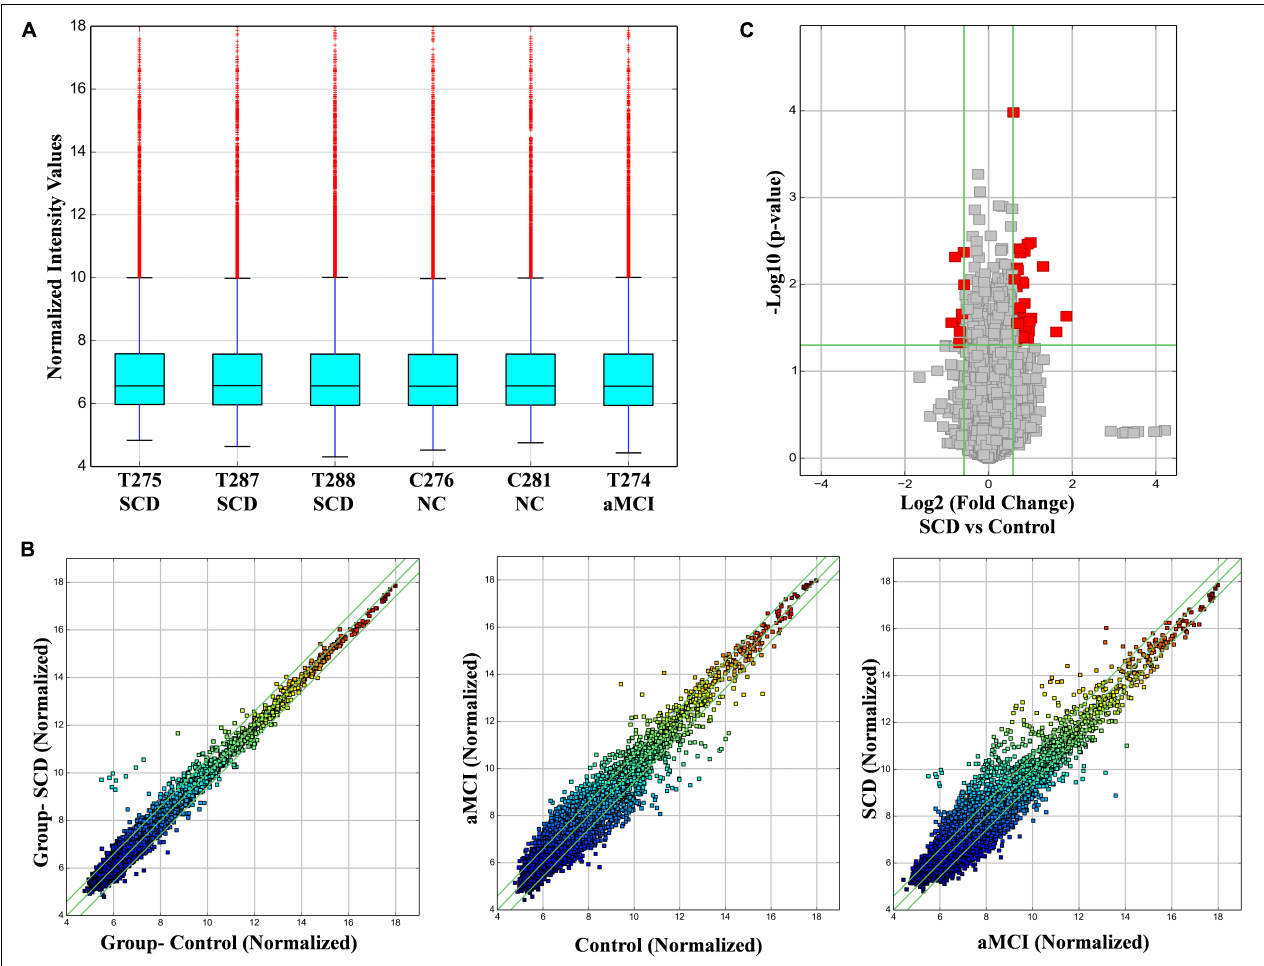
FIGURE 1 | Microarray expression analysis of human circRNAs in SCD and aMCI against control samples. (A) Box plot presenting the normalized intensity values of each sample which are almost the same in each sample. (B) The scatter plots represent the variability of expression between each sample. The values of the X and Y axes in the scatter plot are the normalized signal values of the samples (log2 scaled). The green lines are fold change lines. The CircRNAs above the top green line and below the bottom green line indicated more than a 1.5-fold change of circRNAs between the two compared samples. (C) Volcano plot, showing the red points that represent the differentially expressed circRNAs with statistical significance. The vertical lines correspond to 1.5-fold up and down, respectively, and the horizontal line represents a p -value of